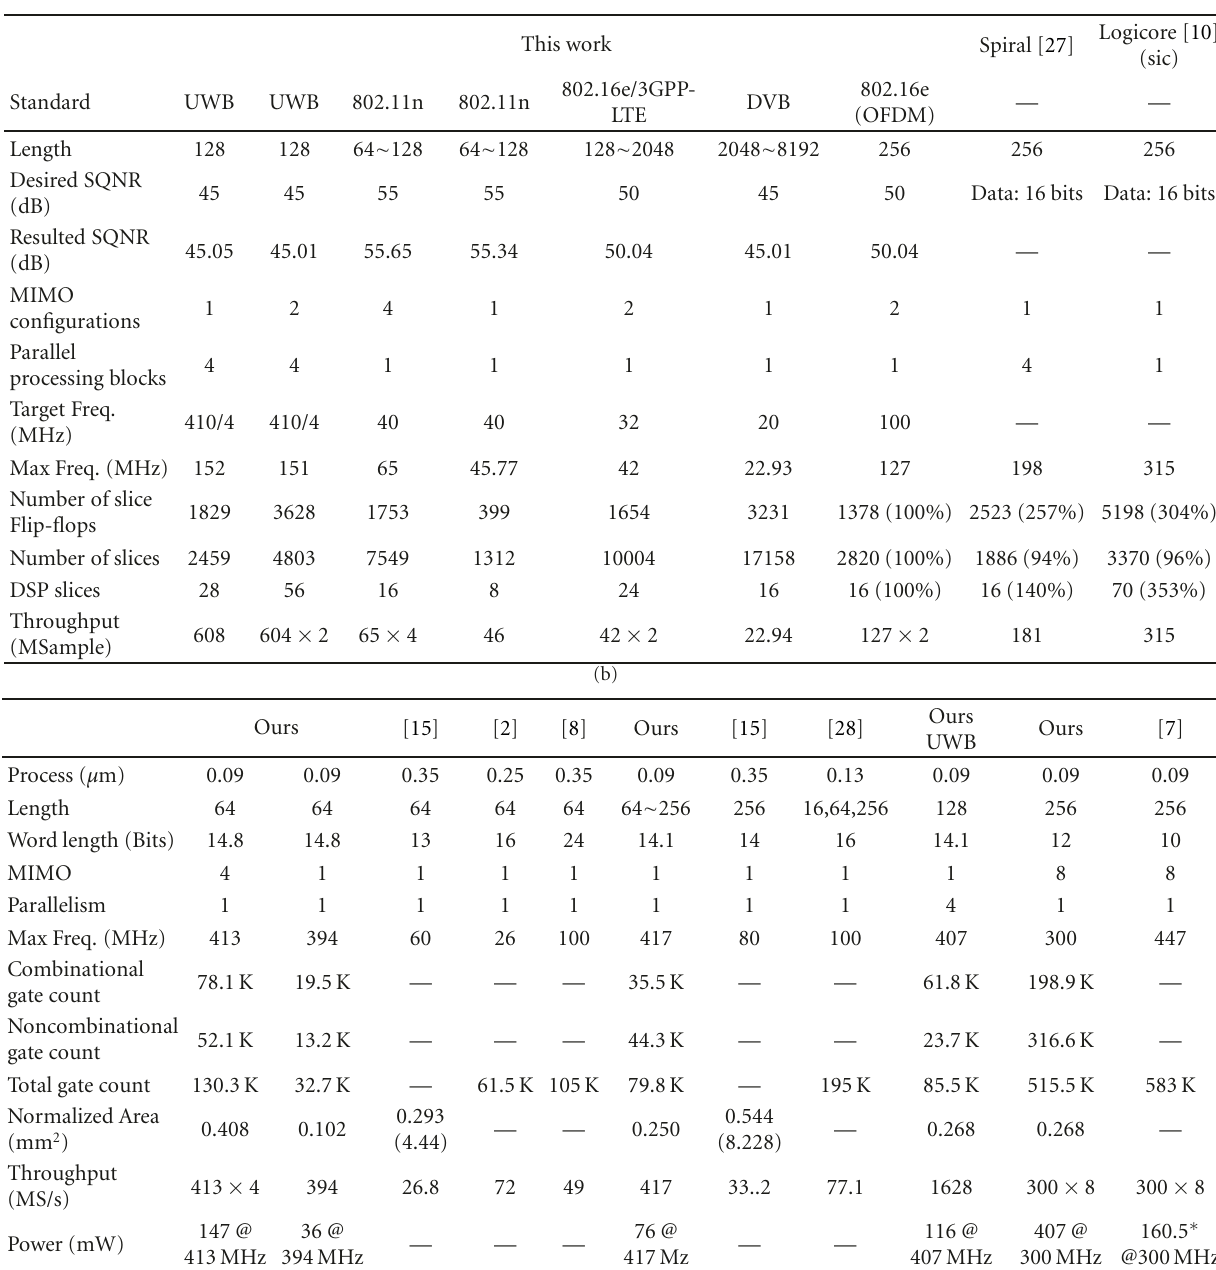
Table 4: Experimental results and comparisons of various generated FFT/IFFT processors implemented (a) by FPGA and (b) by cell-base design flow.